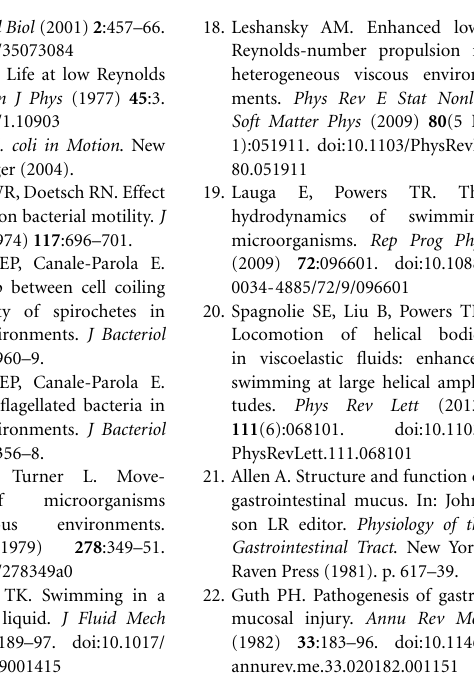
FIGURE 9 |This cartoon illustrates a possible mechanism by which H. pylori gets across the mucus gel . According to Celli et al. (31), gastric mucin forms a gel at low pH < 4.The bacterium cannot move in mucin gels. It secretes urease that metabolizes urea, producing ammonia and elevating the